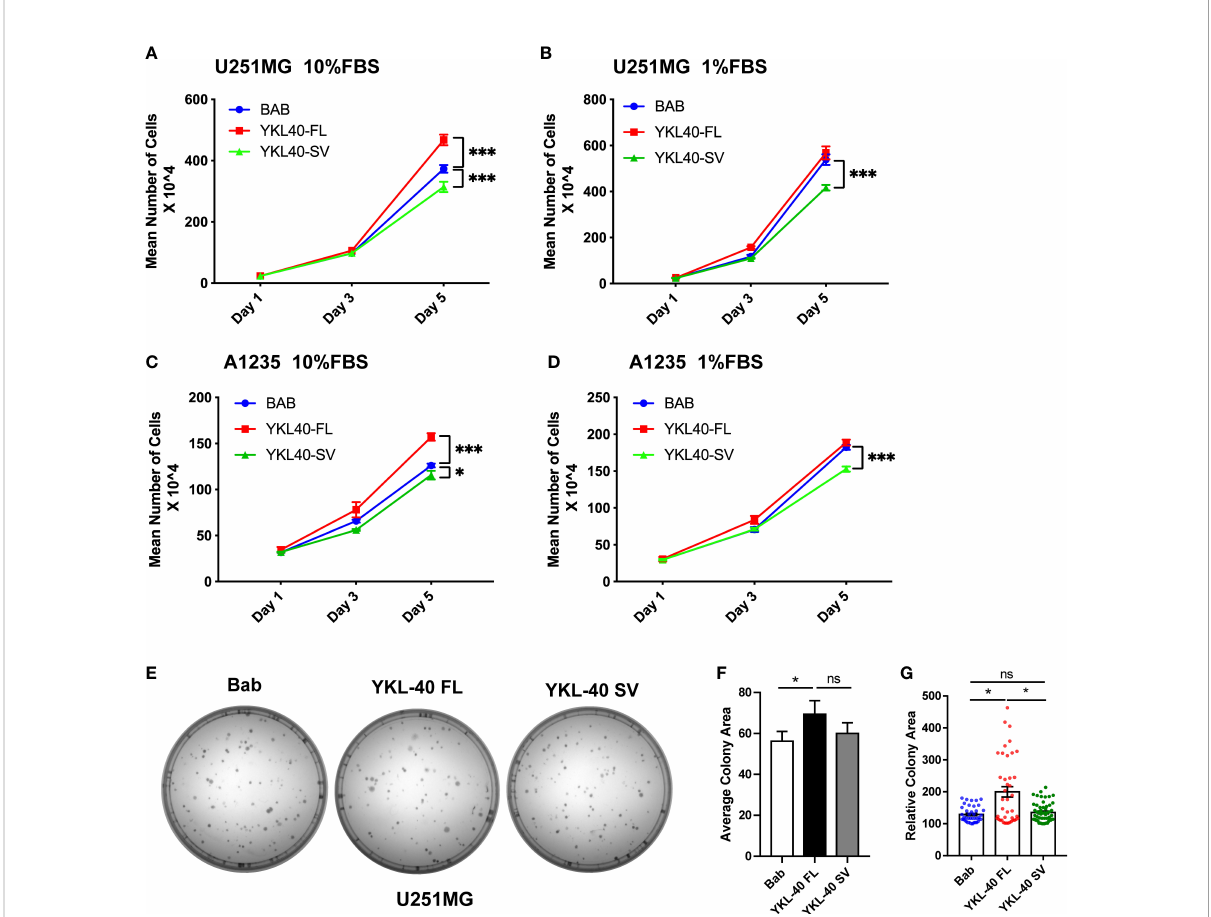
FIGURE 4 Opposing effects of YKL-40 full-length (FL) and short variant (SV) isoforms on cell proliferation. U251MG and A1235 cells were plated into 12-well plates supplemented with full-serum medium (10% FBS) (A, C) or reduced-serum medium (1% FBS) (B, D) , and counted on Days 1, 3, and 5 (Bars, SD. Two-way ANOVA. *** p < 0.001; * p < 0.05). BAB, Blank vector control; YKL40-FL, YKL-40 full-length; YKL40-SV, YKL-40 short variant. N = 4). (E) U251MG cells were seeded into 60 mm culture dishes at a density of 200 cells/plate and cultured for two weeks to form colonies. The cell colonies were stained with crystal violet. (F, G) Colony areas were quanti fi ed by Fiji-ImageJ software. (Bars, SD. One-way ANOVA. * p < 0.05; ns, no signi fi cant difference. n = 3) The relative colony area was calculated from 40 to 60 individual